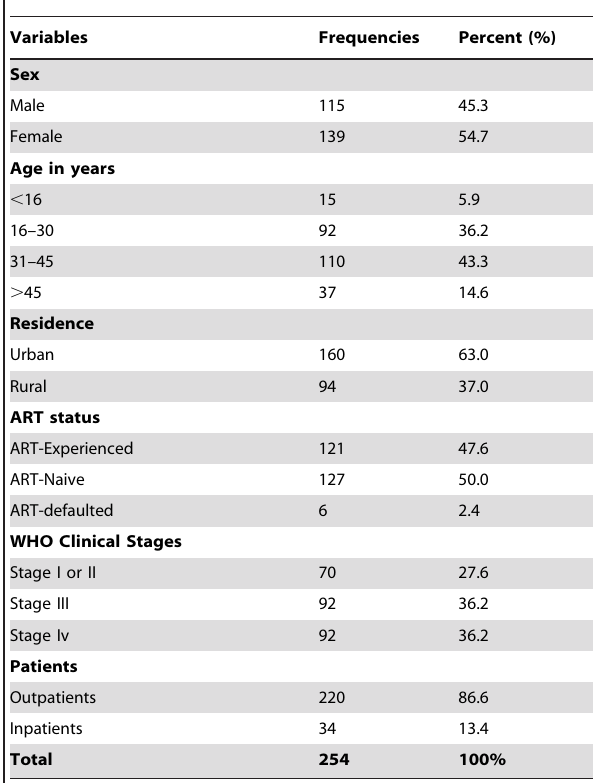
Table 1. Demographics of